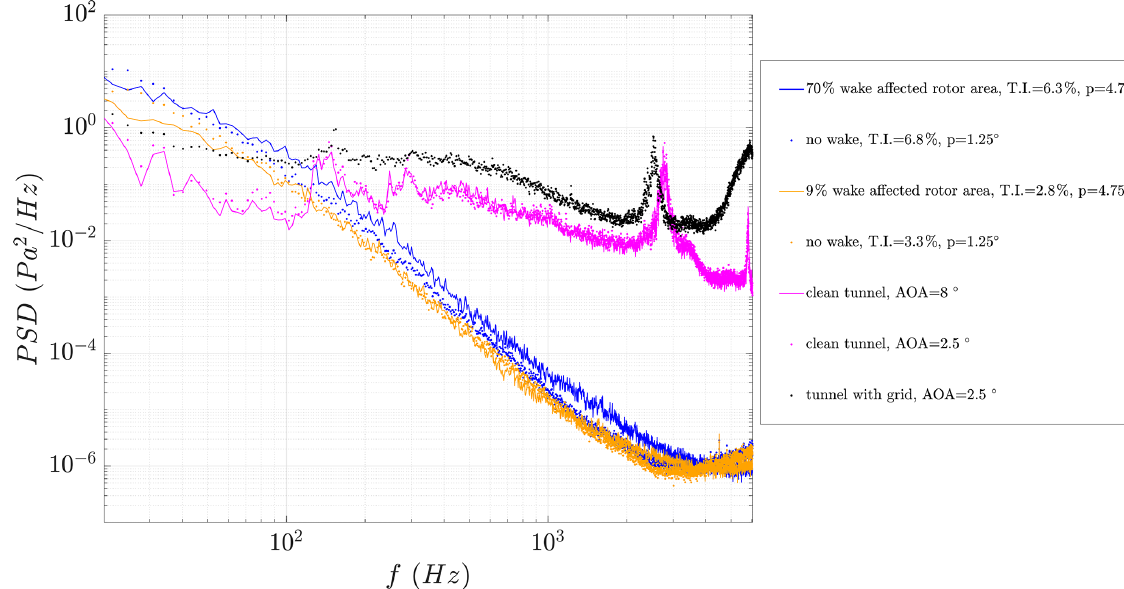
Figure 3. Inflow spectra characterized by the pressure fluctuations in the laminar boundary layer for wind tunnel and field experiments obtained by a microphone placed at x/c = 0 . 2% on the pressure side.